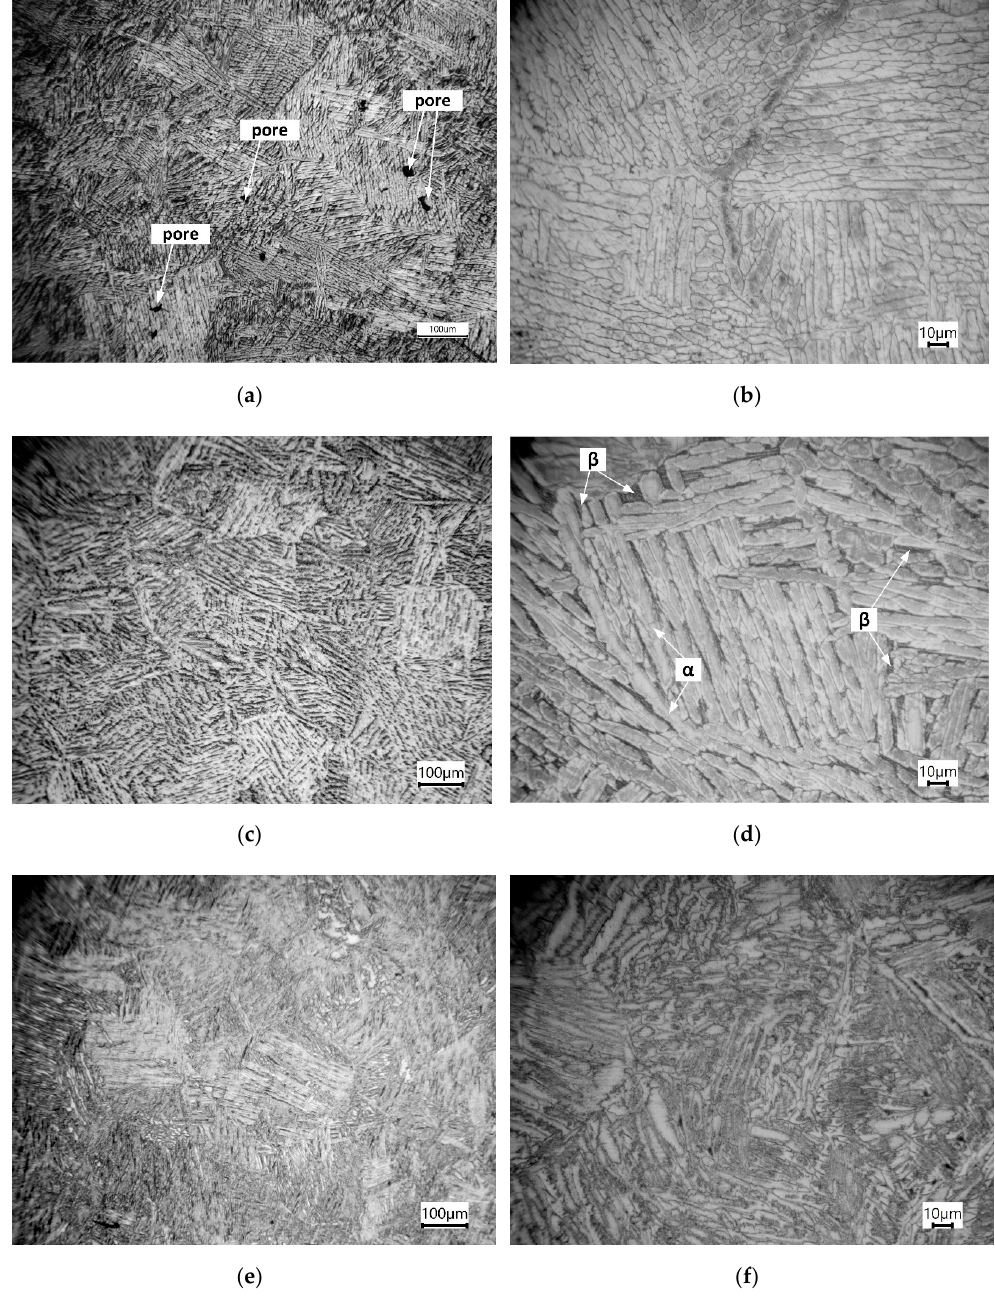
Figure 7. Microstructure of sample no. 1, the «parallel» technique: ( a , b ) Direction 1 according to Figure 5b; ( c , d ) direction 2; ( e , f ) direction 3.